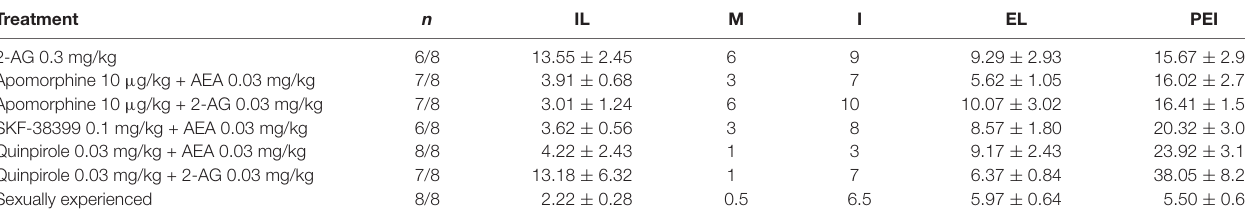
TABLE 2 | Specific sexual behavior parameters of those sexually satiated male rats achieving ejaculation in response to drug treatment and of a group of sexually experienced male rats as a reference. Treatment n IL M I EL PEI 2-AG 0.3